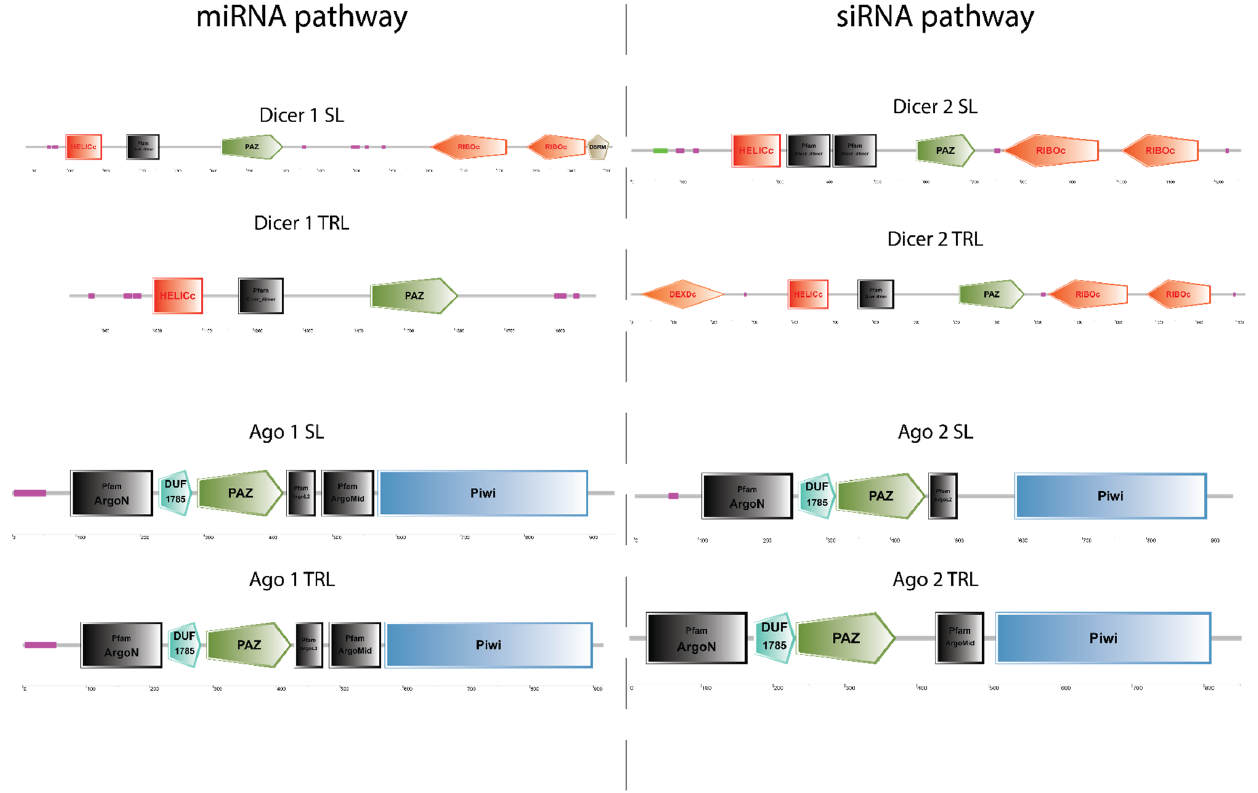
Figure 2. Domain architecture across core small interfering RNA (siRNA) and microRNA (miRNA) pathways in the slipper lobster Thenus australiensis (SL) and the ornate tropical rock lobster Panulirus ornatus (TRL). Architecture was resolved via SMART in NORMAL mode using miRNA gene se- quences (Dicer 1 and Ago 1) and siRNA gene sequences (Dicer 2 and Ago 2) from both species. Purple/pink boxes represent regions of low complexity, black domains represent domains from the PFAM database, and all others are from the SMART database. 2.2. Variable Expression of siRNA and miRNA Genes in P. ornatus across Metamorphic Stages As both P. ornatus and T. australiensis possess the core RNAi machinery, and silencing has been induced in slipper lobsters but not spiny lobsters, the expression of the genes involved in the siRNA and miRNA pathways was analysed in both species [67]. For P. ornatus , we had access to a comprehensive transcriptome library including multiple life stages, and multiple adult tissues [68,69]. In T. australiensis however, there is only one dataset produced recently (unpublished data) which contains the sub adult tissues, mak- ing direct comparison difficult between both species. Across the metamorphic stages of P. ornatus (described in Hyde et al. (2019)), expres- sion of genes in both the siRNA and miRNA pathways were variable and appear to change significantly based on life stage, however overall, expression was very low ( ≤ 2.0 RPKM; Figure 3) [68]. In the miRNA related genes, Dicer 1 and Ago 1 both peaked in expression at the gut retraction stage with relatively stable levels of expression preceding this spike (Figure 3B). After the peak, Dicer 1 expression dropped back to very low levels (RPKM < 0.2), while Argonaute 1 dropped in expression, then rose again in the pigmented and Juv-0 stage before dropping again in the Juv-4 stage (Figure 3A). Drosha had rela- tively consistent expression until after the gut retraction stage where it began to rise slowly before decreasing towards the Juv-4 stage (Figure 3A). Pasha like Dicer 1 had very